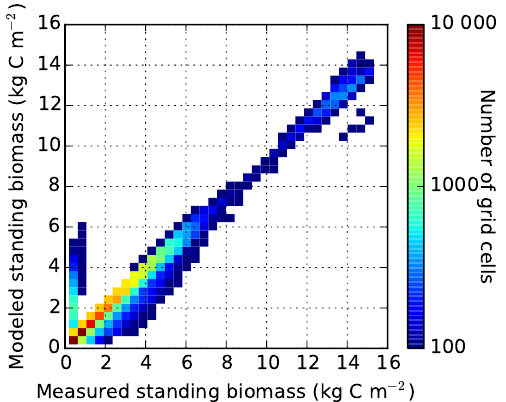
Figure 5. Comparison of modeled standing biomass with the com- pilation from Avitabile et al. (2016) and Santoro et al. (2015). Bins with fewer than 100 grid cells are